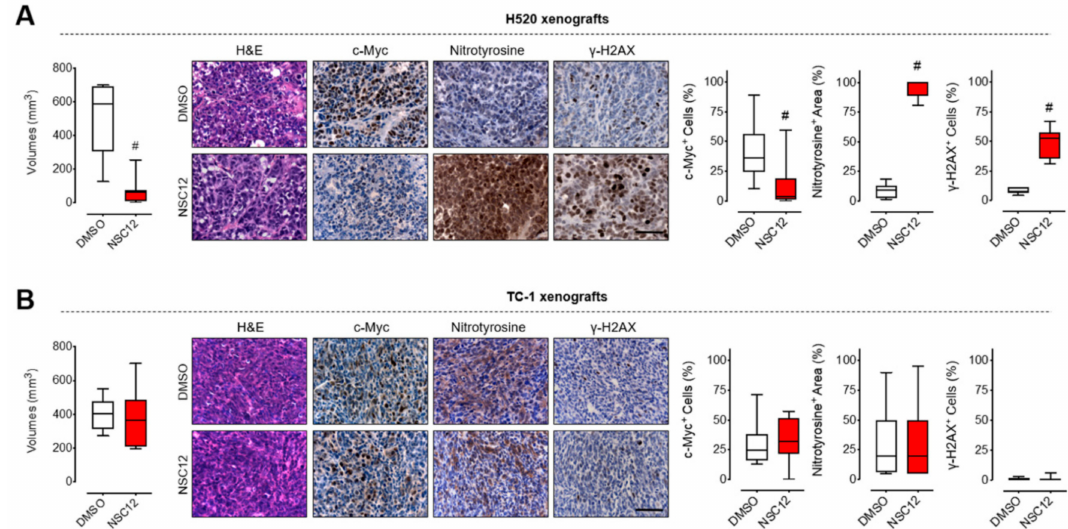
Figure 5. In vivo c-Myc modulation, oxidative stress and DNA damage mediated by FGF trapping are specific for FGF-dependent lung cancers. ( A ) FGF-dependent H520 tumor xenografts. ( B ) FGF-independent TC-1 tumor xenografts. Left panels: volumes of subcutaneous tumors 23 days post-implantation treated with NSC12 (7.5 mg / kg) or control / vehicle DMSO. Middle panels: histological analyses of DMSO- or NSC12-treated tumors 23 days post-implantation. Right panels: quantification of c-Myc, nitrotyrosine and γ -H2AX positivity by using ImageJ software. In box and whiskers graphs, boxes extend from the 25th to the 75th percentiles, lines indicate the median values and whiskers indicate the range of values. n = 10 mice / group, # p <